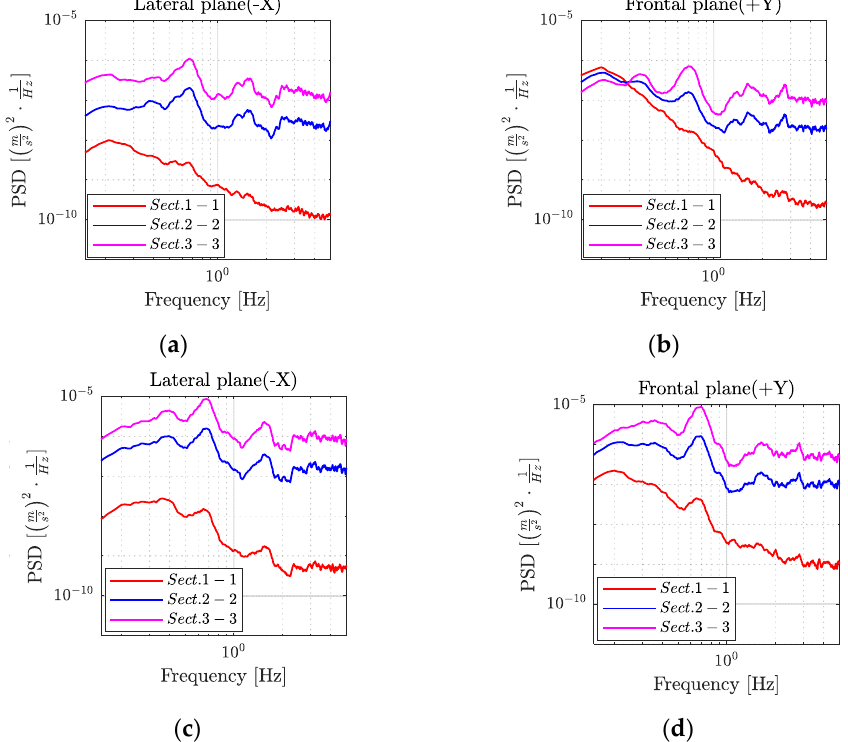
Figure 8. ( a ) The PSDs in the x-direction during Test #3; ( b ) the PSDs in the y-direction during Test #3; ( c ) the PSDs in the x-direction during Test #8; ( d ) the PSDs in the y-direction during Test #8.